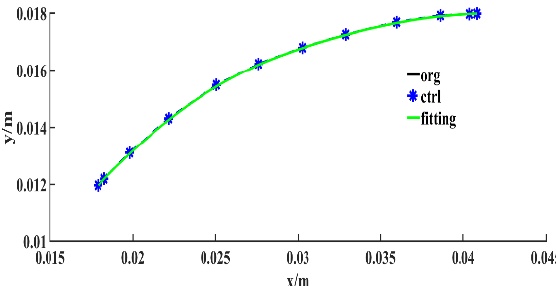
Figure 6. The parameterization of camber line.